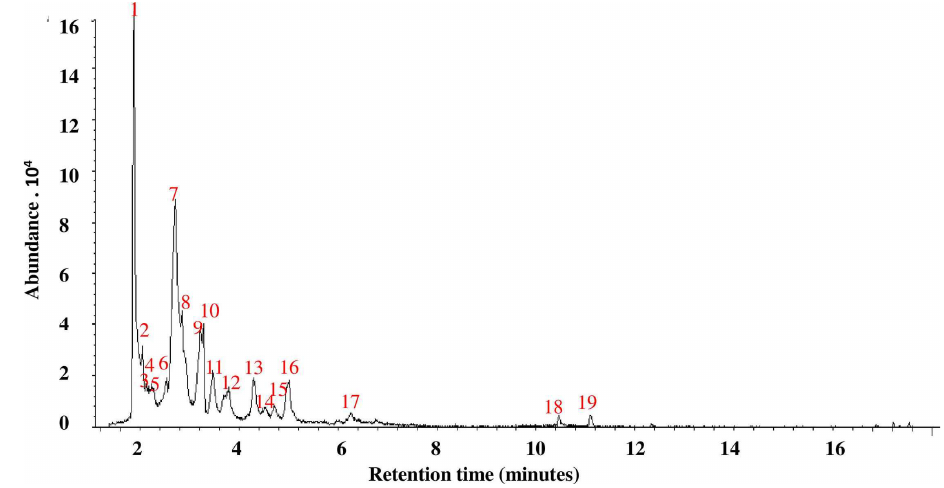
Figure 2. GC-MS analysis of P. ostreatus aqueous extract.